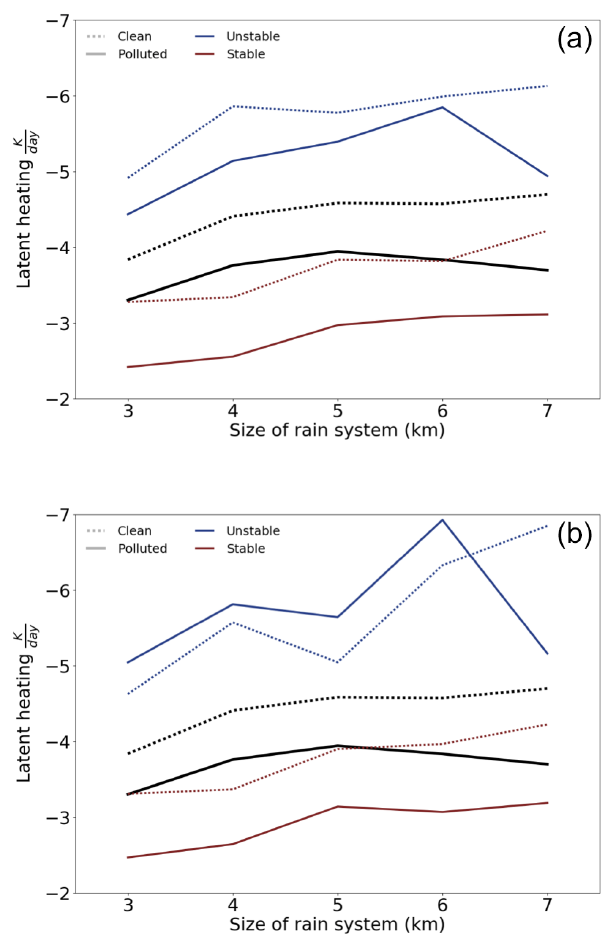
Figure 4. The maximum rate latent heating released due to evapo- ration above the cloud as a function of rain system size for all (a) and dry (b) warm clouds with an extent of 15km. Black is for all stabilities, blue is for unstable environments, and red is for stable environments; dashed represents pristine and solid represents pol- luted